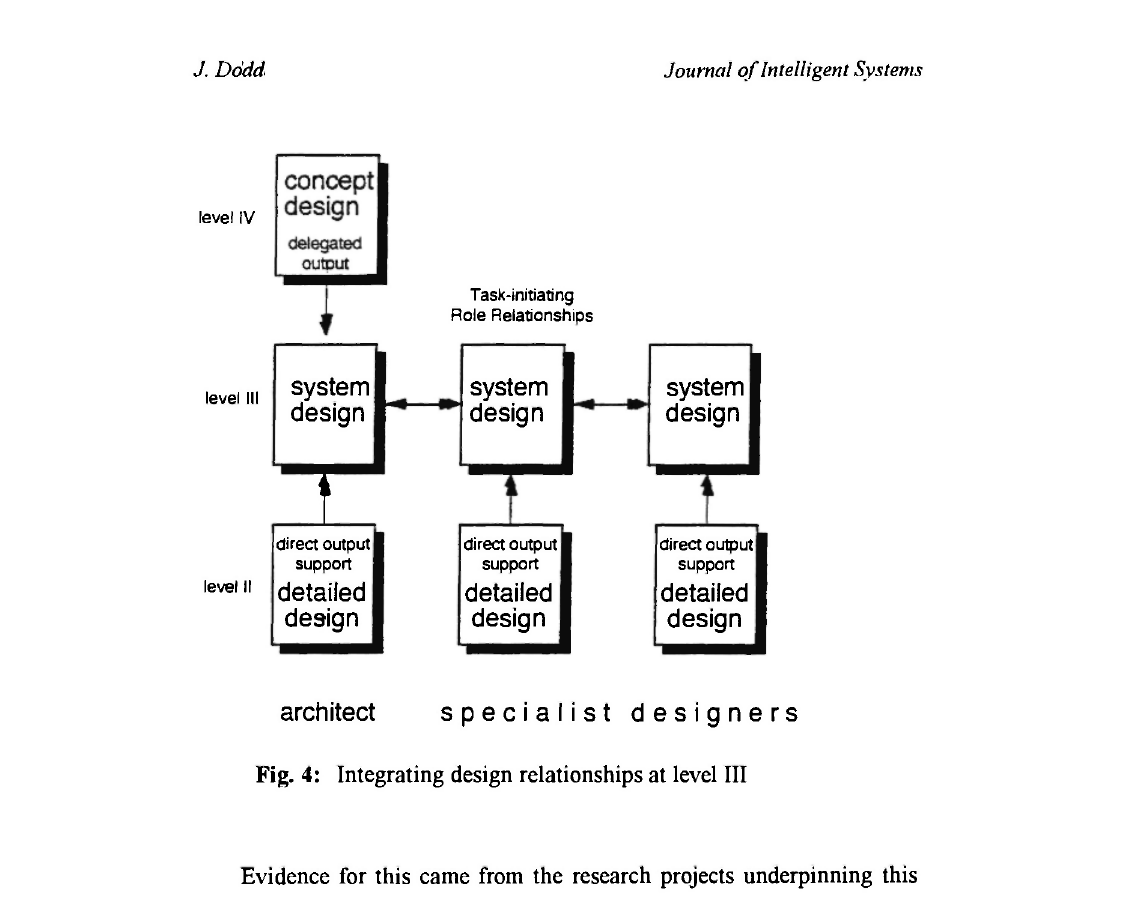
Fig. 4: Integrating design relationships at level